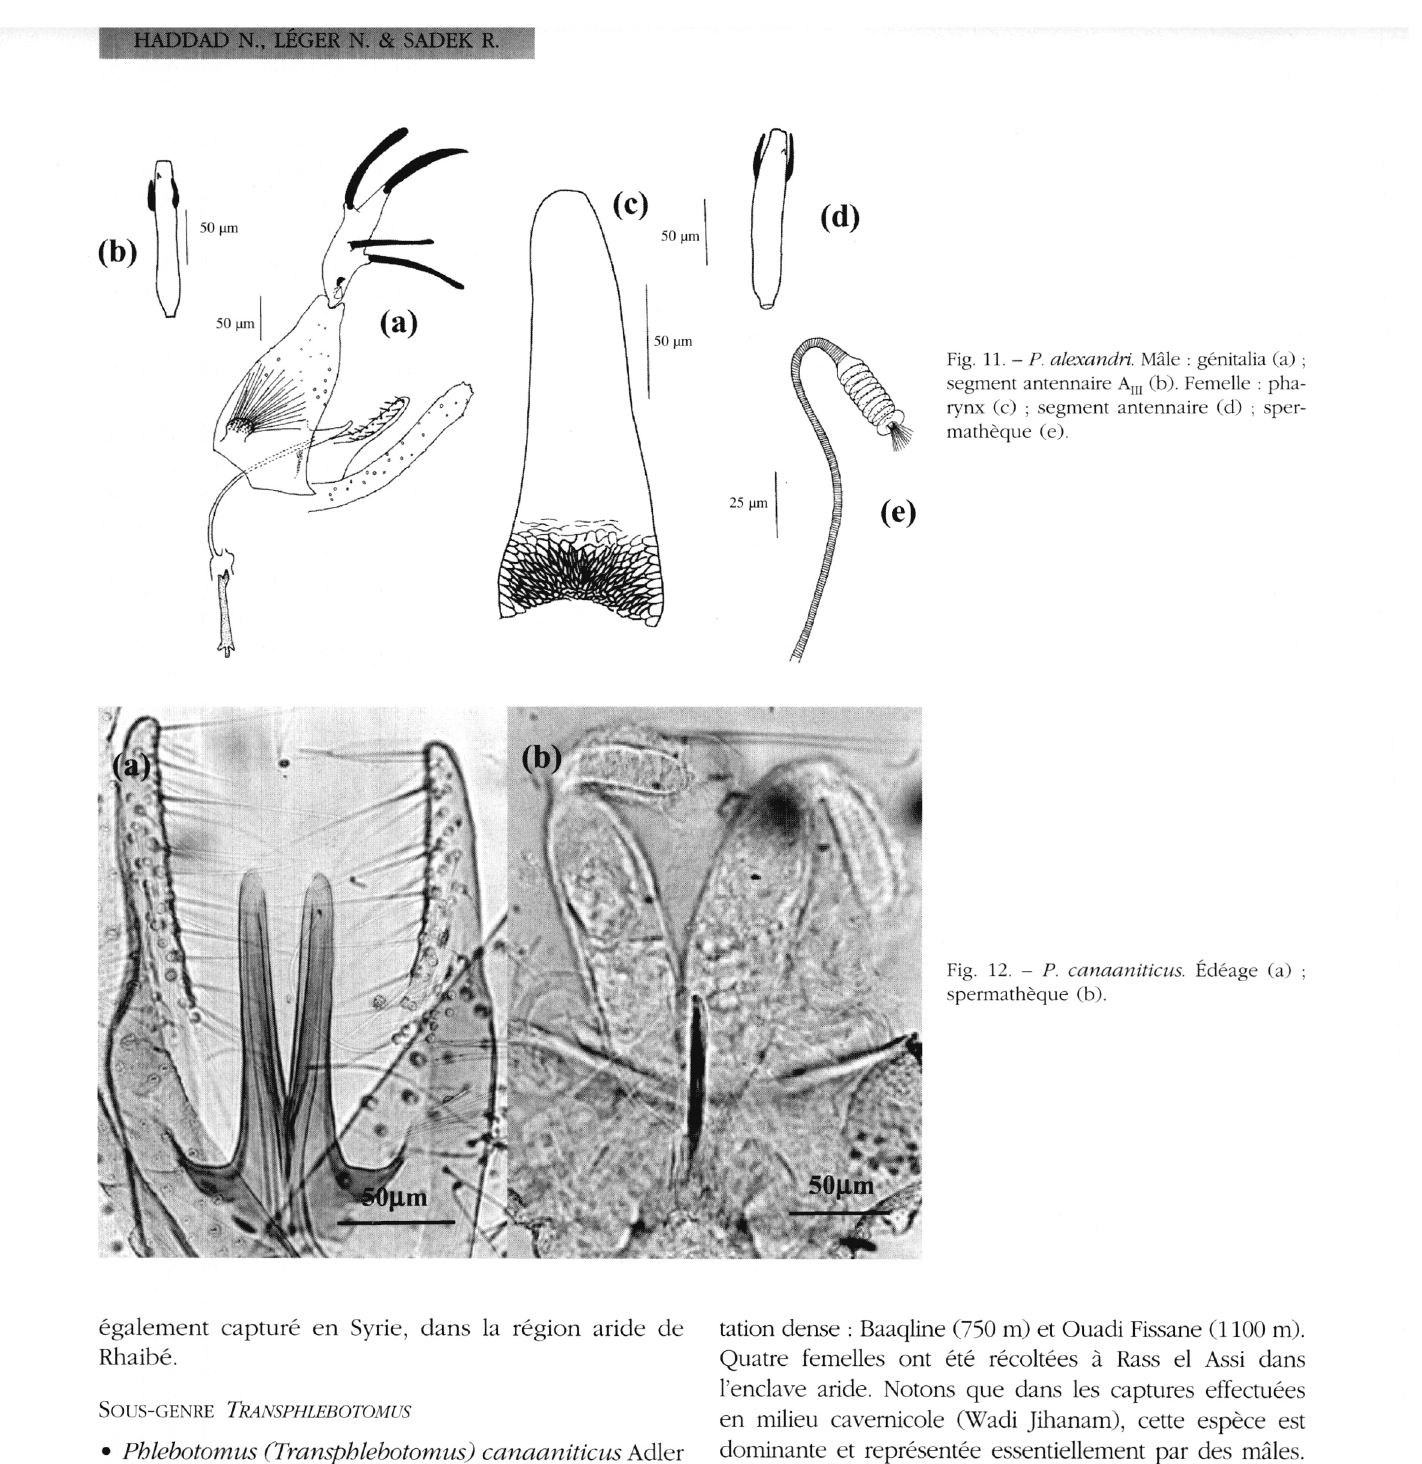
également capturé en Syrie, dans la région aride de Rhaibé.